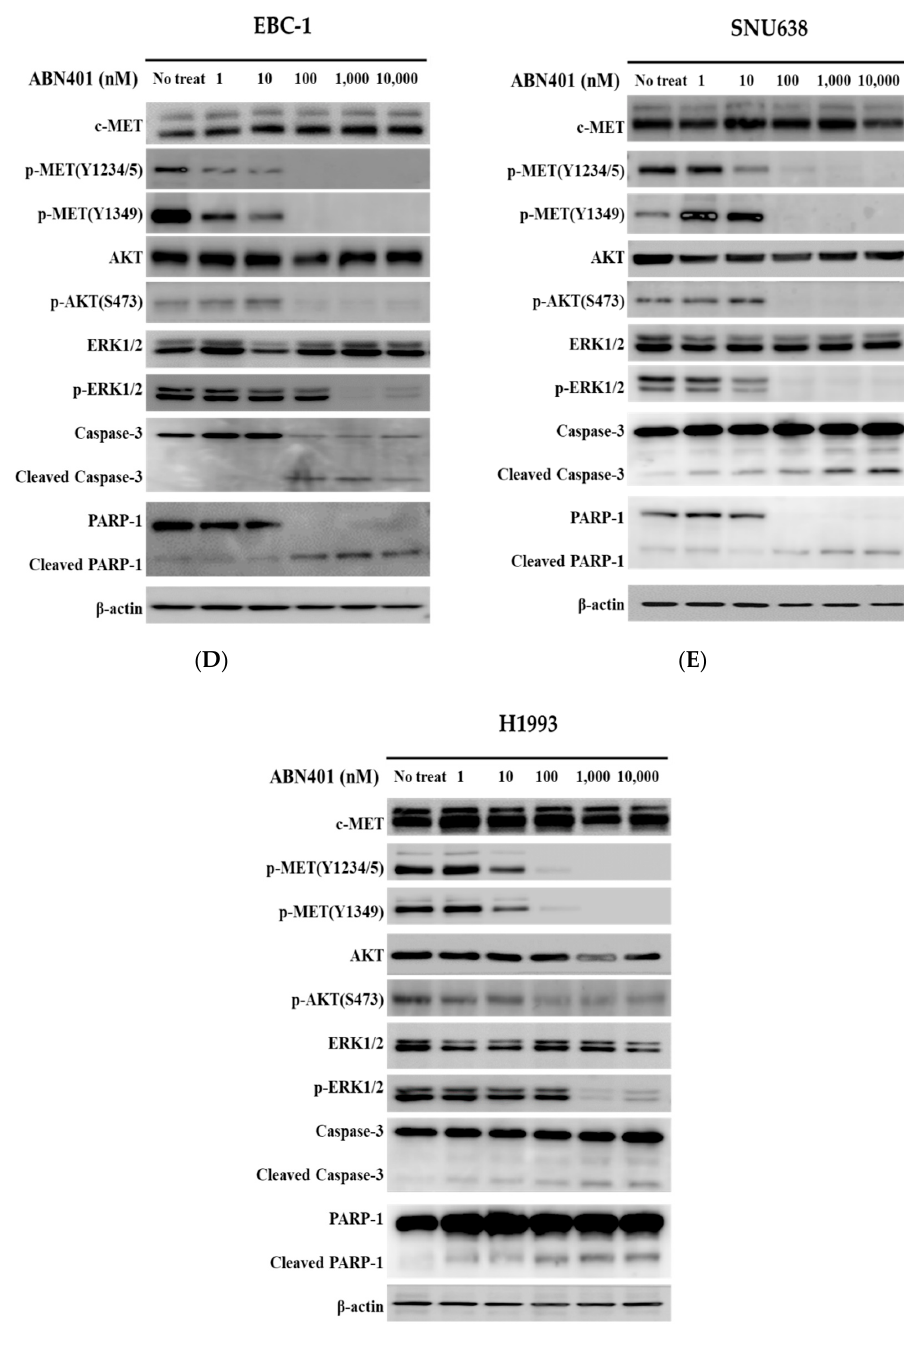
Figure 2. Cytotoxic activity of ABN401 in vitro and effect of ABN401 on MET signaling in MET -addicted cancer cells. ( A ) MET -addicted cancer cell lines and normal immortalized cells were treated with ABN401 for 72 h, and cell viability was assessed using the WST assay. Data are expressed as the mean ± standard deviation (SD) from three sextuplicate independent experiments. ( B ) SNU5, ( C ) Hs746T, ( D ) EBC-1, ( E ) SNU638, ( F ) H1993 cancer cell lines with MET protein overexpression and/or MET -high amplification and/or MET exon1 14 skipping treated with different concentrations of ABN401 for 72 h were harvested and examined by Western blotting. Western blotting data are representative of three independent experiments. Comparisons between the control (no treatment group) and treatment groups were performed using the t -test. ** p <